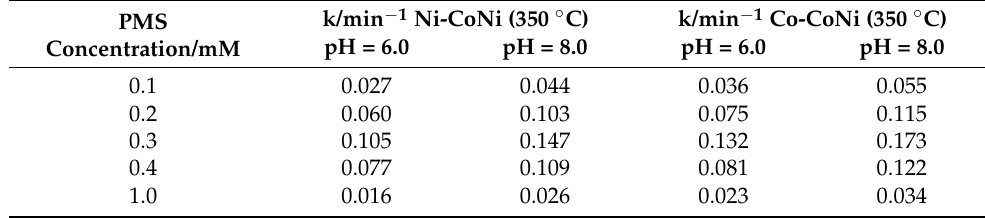
Table 3. Kinetic constants of the degradation of TCs as a function of the concentration of